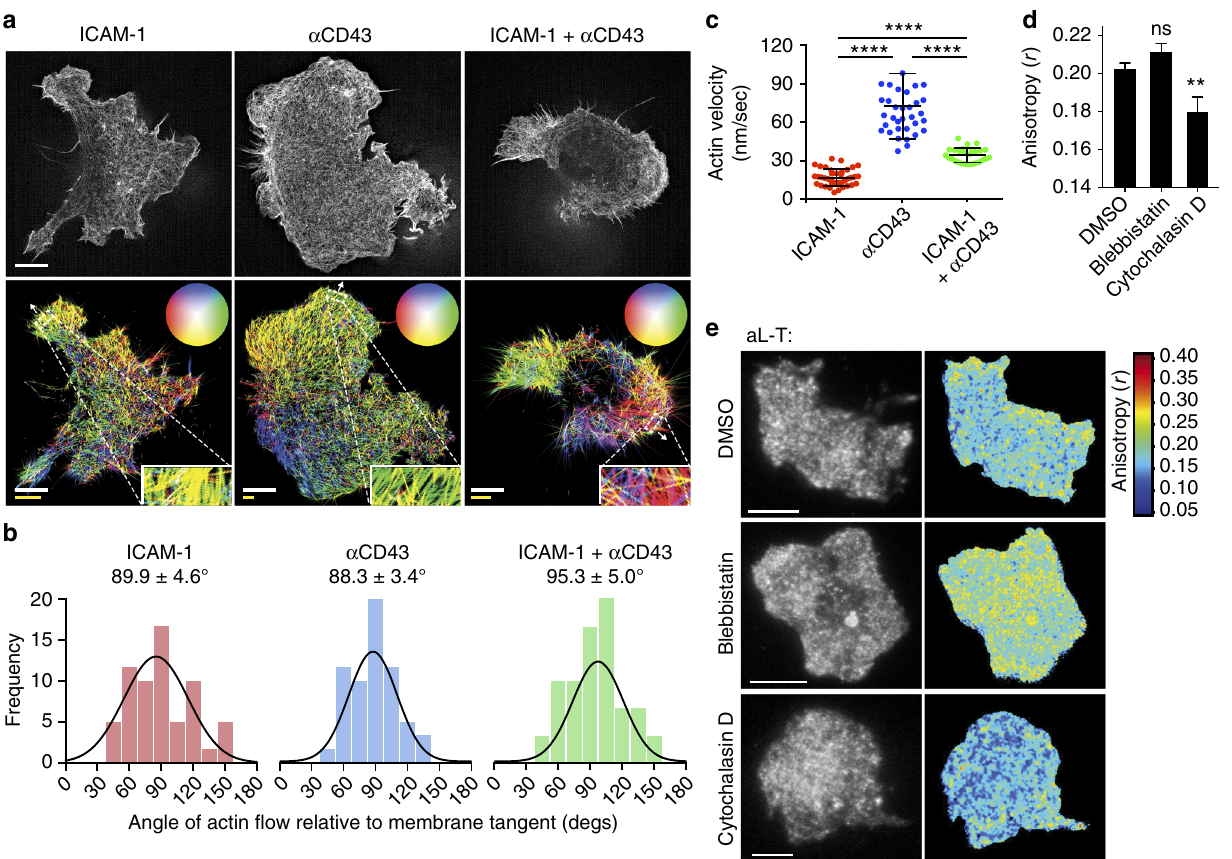
Fig. 3 Actin fl ow dynamics, orientation, and relation to GFP-LFA-1 anisotropy in migrating T cells. a Representative frames of structured illumination microscopy movies (above) of the actin cytoskeleton visualized with lifeact-mNeonGreen in Jurkat T cells migrating on ICAM-1 (10 µ g/ml), anti-CD43 IgG (10 µ g/ml), or their mixture (10 µ g/ml each). Optical actin fl ow vector maps of the same cells are shown below with zoom insets of representative areas. Vectors encode fl ow direction by color (circular keys in the direction from center of circle to perimeter) and velocity by length. Scale bars encode dimensions in the micrograph (white, 5 µ m) and velocity (yellow, 30 nm/s). b Actin fl ow direction relative to tangent of leading edge membrane. Bins of 15° are shown with Gaussian fi t and mean ± SEM. ICAM-1, N = 62; α CD43, N = 63; ICAM-1 + α CD43, N = 67. ROI (N) came from six to eight cells. c Leading edge actin fl ow velocity from optical fl ow analysis. Plots show data on each cell. Bars show mean ± s.d. Two-tailed Mann – Whitney tests all show p < 0.0001 (****). ICAM-1, N = 39; α CD43 N = 38; and ICAM-1+ α CD43, N = 25. d , e Jurkat T cells migrating on ICAM-1 (10 µ g/ml) expressing α L-T-GFP were treated with DMSO as control, blebbistatin (100 µ M), or cytochalasin D (100 nM) and fi xed. d Whole-cell emission anisotropy analyzed as in Fig. 2e with error bars showing SEM of three independent experiments. Mann – Whitney test for DMSO ( N = 37) vs. blebbistatin ( N = 9) was 0.130 and for DMSO vs. cytochalasin D ( N = 14) was 0.003. ** p < 0.01. e Representative total fl uorescence intensity ( I || + 2 I ⊥ , left) and anisotropy (right). Scale bars: 5 µ